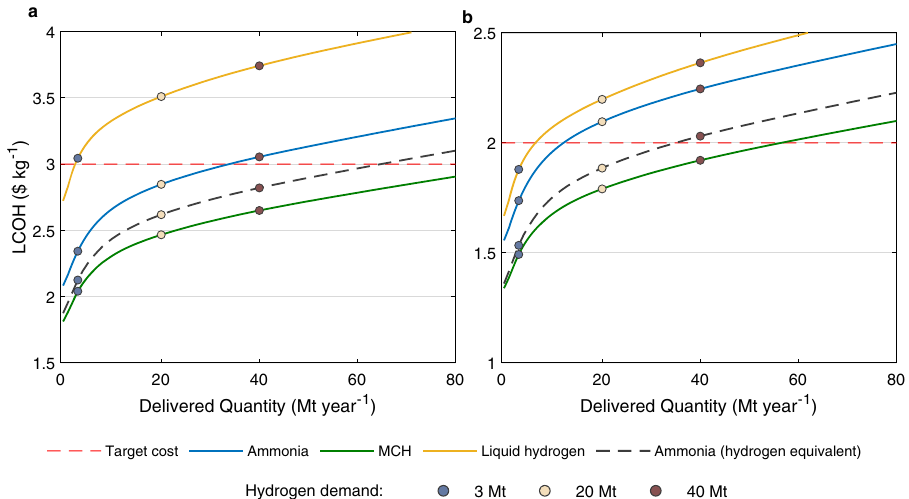
Fig. 1 Supply curves for hydrogen produced from offshore wind in China and delivered to Japan. a and b are for 2030 and 2050, respectively. Results from the baseline scenario are presented. The levelized cost of hydrogen (LCOH) is calculated as the weighted average cost for the cumulative quantity of hydrogen. Data for the three transport mechanisms are represented by solid curves with different colors. Data for delivery of ammonia without dehydrogenation at the destination are shown in gray dashed curves. Projections of hydrogen demand in Japan are tagged by colored circles. The targeted hydrogen costs for Japan are indicated with red dashed lines. MCH represents the hydrogen transport mechanism as in